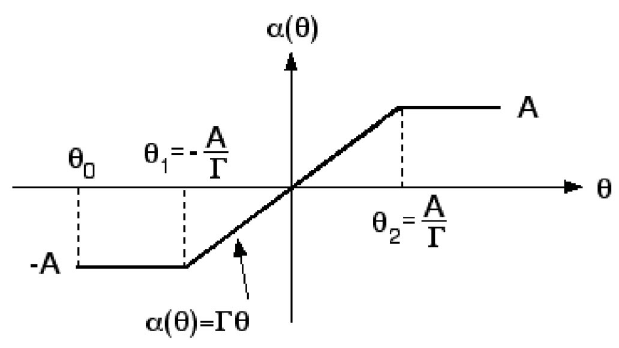
FIG. 4. Crossing a resonance in a sloped-step